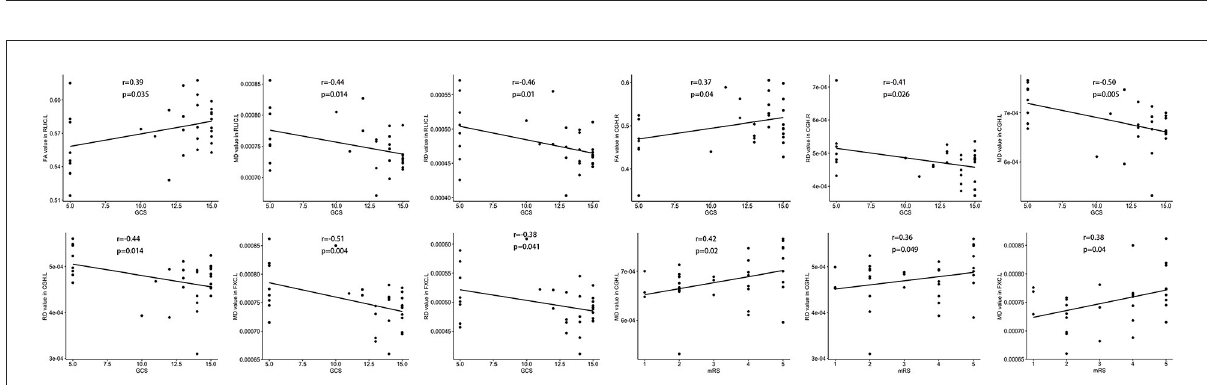
FIGURE3 Correlation between white matter damage and GCS or mRS score in patients with anti-NMDAR encephalitis. FA, fractional anisotropy; MD, mean diffusivity; RD, radial diffusivity. All brain region abbreviations are listed in Supplementary Table